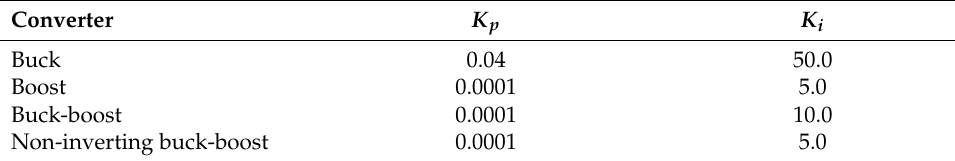
Figure 3. Mean absolute error of the output voltage in each converter (the best response in the red circle): ( a ) Buck converter, ( b ) Boost converter, ( c ) Buck-boost converter, and ( d ) Non-inverting buck-boost converter. Table 3. Selected PI constants for each one of the studied